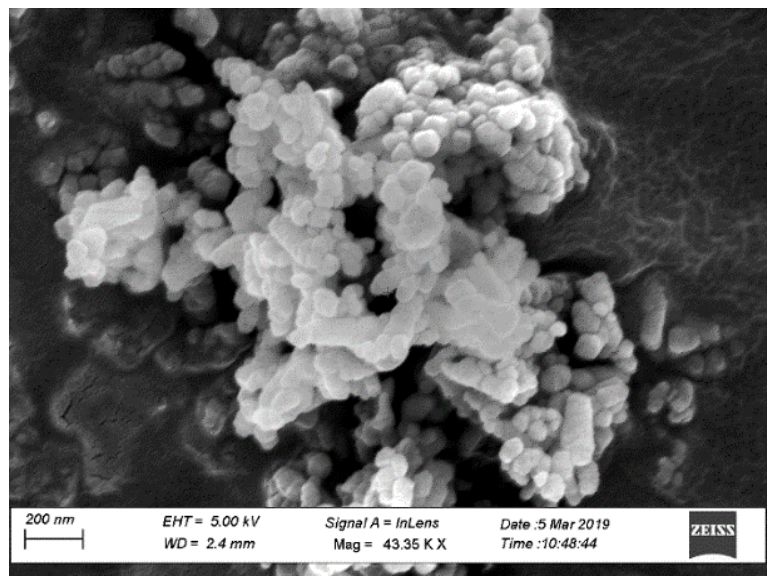
Figure 2. Nano CaCO 3 under Scanning Electron Microscope (SEM).